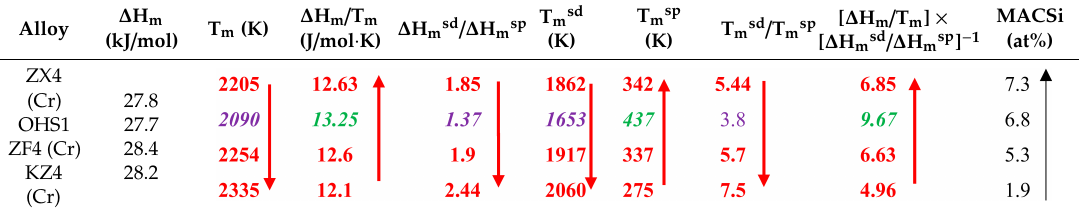
Table 6. Alloy parameters for the macrosegregation of Si in the cast alloys KZ4, ZF4, ZX4, and OHS1 considering the Cr e ff ect with Ge and Sn individually (indicated by (Cr) next to the alloy designation) and simultaneously (alloy OHS1). Bold red numbers and arrows represent strong trends (excluding the Sn + Ge synergy in OHS1), while bold italics represent minima (in purple) and maxima (in